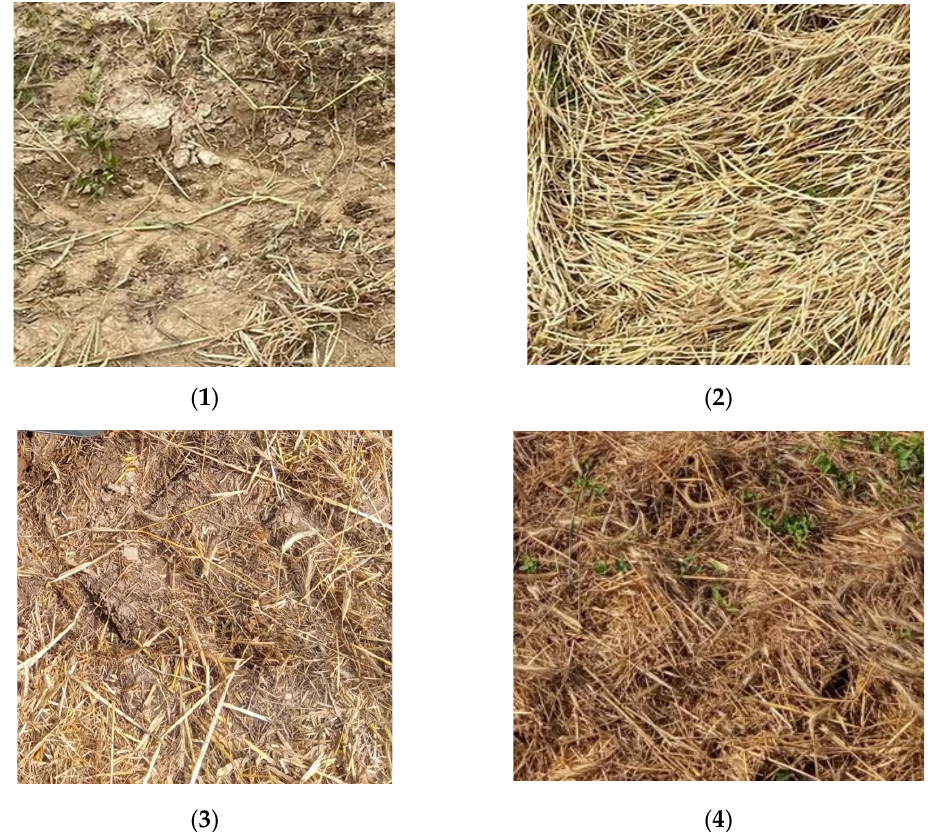
Figure 3. Effect of the four different cover crop managements compared in the experiment: ( 1 ) bare soil (Bare); ( 2 ) roller crimper (Crimped); ( 3 ) harvested canopy (Harvested); ( 4 ) flail mower (Shredded). Table 1. Technical data of the tractor used in the